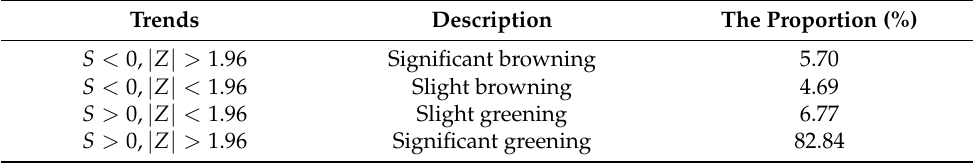
Table 3. Trend analysis statistics of NDVI.